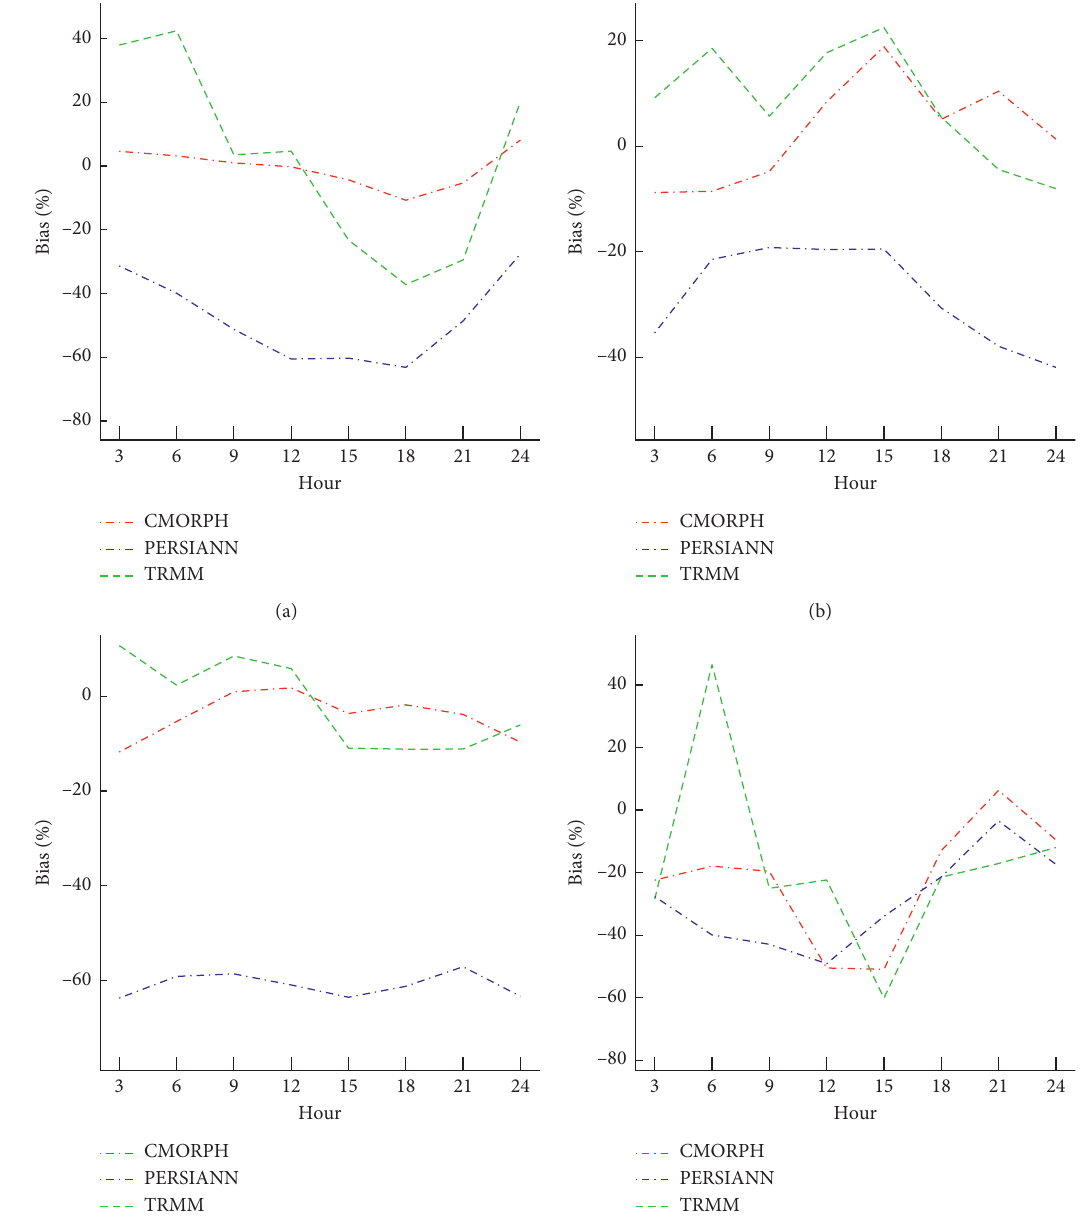
Figure 4: The average bias rate of each satellite dataset over the Three Gorges Reservoir area in (a) spring, (b) summer, (c) autumn, and (d)